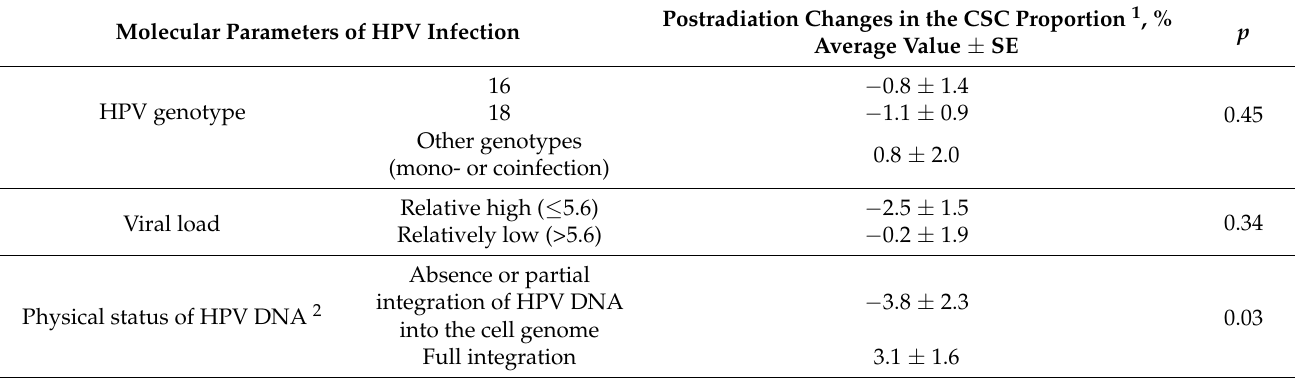
Table 2. Postradiation changes in the proportion of CD44 + CD24 low CSCs in subgroups of patients with various molecular parameters of human papillomavirus (HPV)